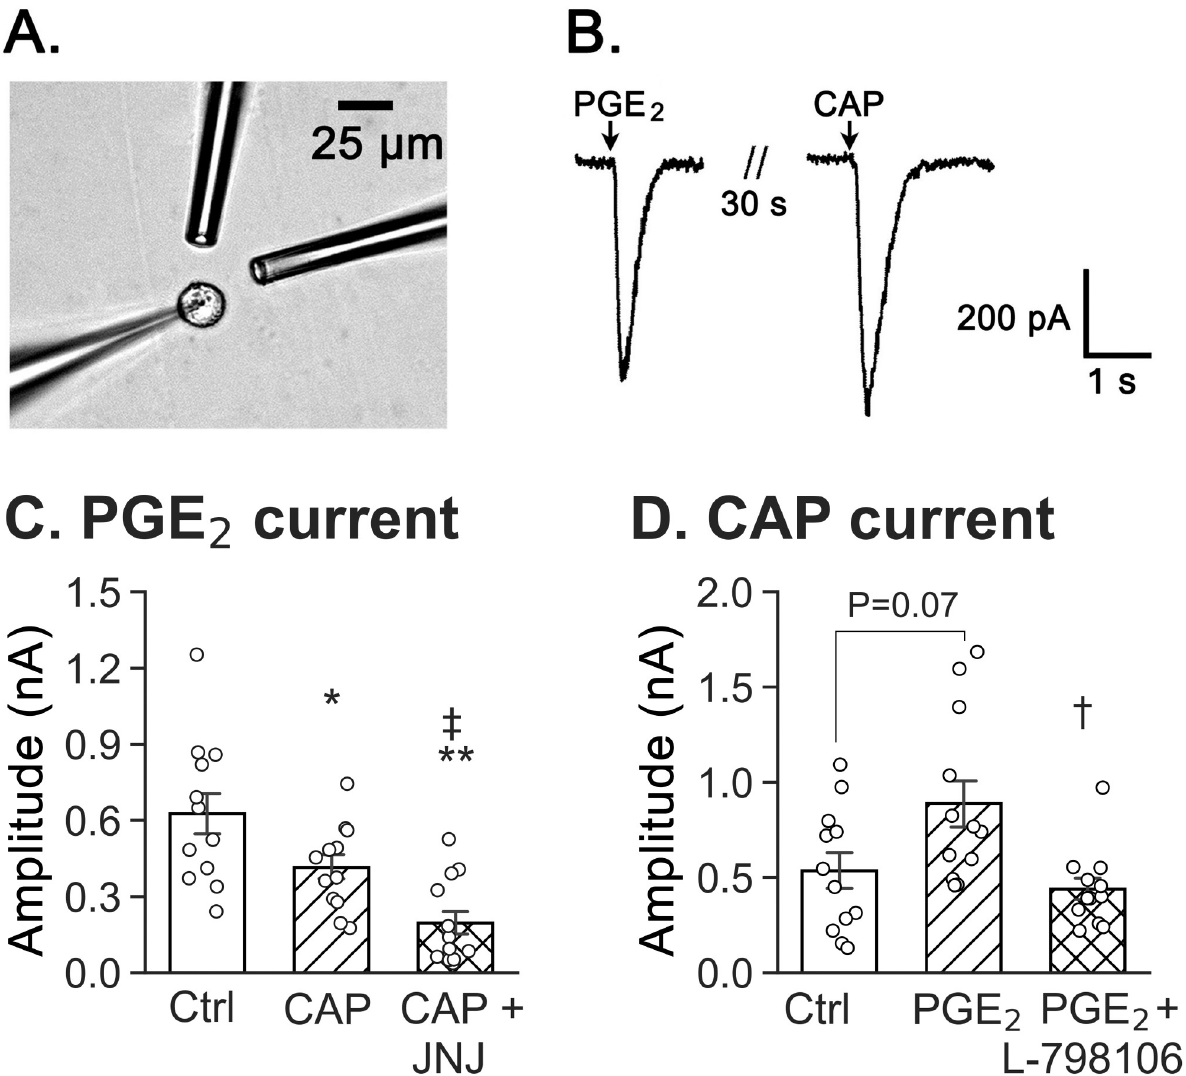
Fig 6. Cross-effect between CAP and PGE 2 on the evoked currents of vagal pulmonary C-neurons. A: A recording electrode on a vagal pulmonary C-neuron retrogradely traced by DiI is surrounded by two adjacent pipettes for drug delivery with ~15 μ m distance to the neurons. B: PGE 2 - and CAP-induced currents in a vagal pulmonary C-neuron with an interval of 30 s between the stimulations. C: The PGE 2 -induced currents are inhibited by ~33% after CAP-pretreatment alone and by ~69% after CAP-pretreatment coupled with TRPV1 antagonist. D: PGE 2 -pretreatment enhances CAP- induced currents via acting EP3 receptor. n = 12/group, � P < 0.05 and �� P < 0.01 as compared to Ctrl. † P < 0.05 and ‡ P < 0.01, CAP + JNJ (JNJ 17203212) vs. CAP pretreatment or PGE 2 + L-798106 vs. PGE 2